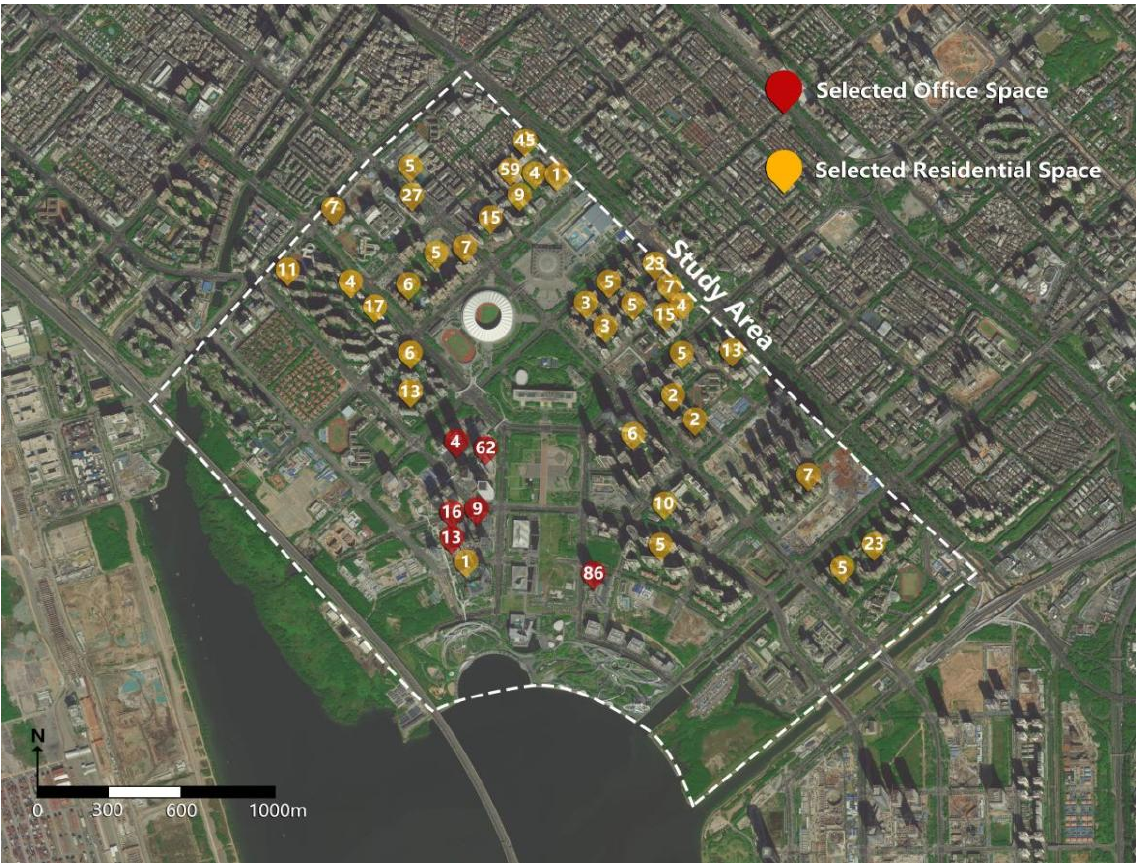
Figure 4. Distribution of samples (source: authors).